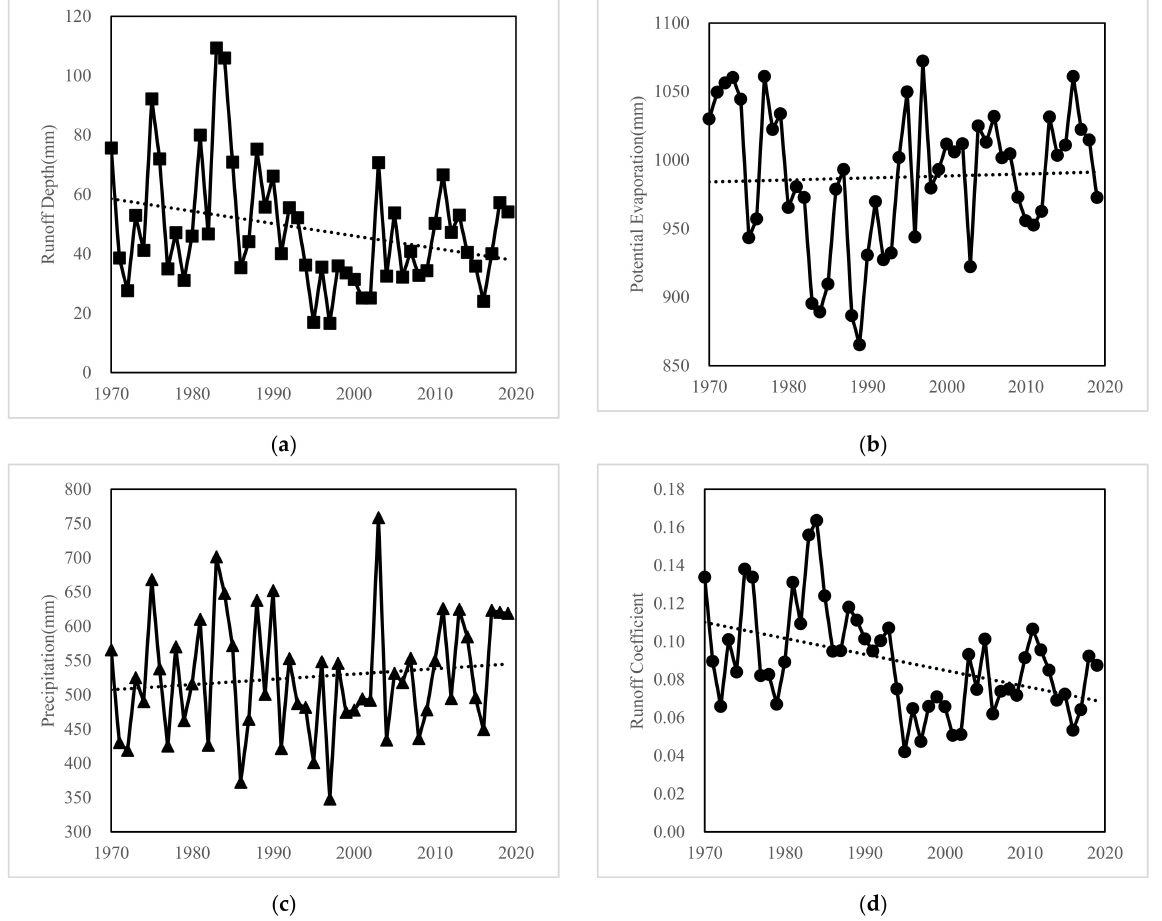
Figure 2. Trend of hydrological elements in the Weihe River basin. ( a ) Runoff Depth. ( b ) Potential Evapotranspiration. ( c ) Precipitation. ( d ) Runoff